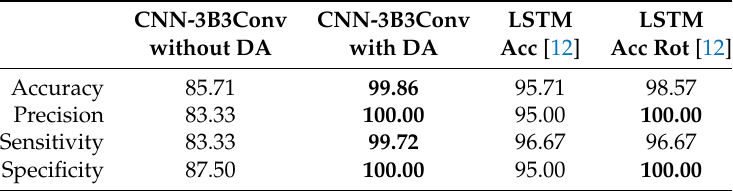
Table 1. Fall detection results (in %) when using the URFD data set.